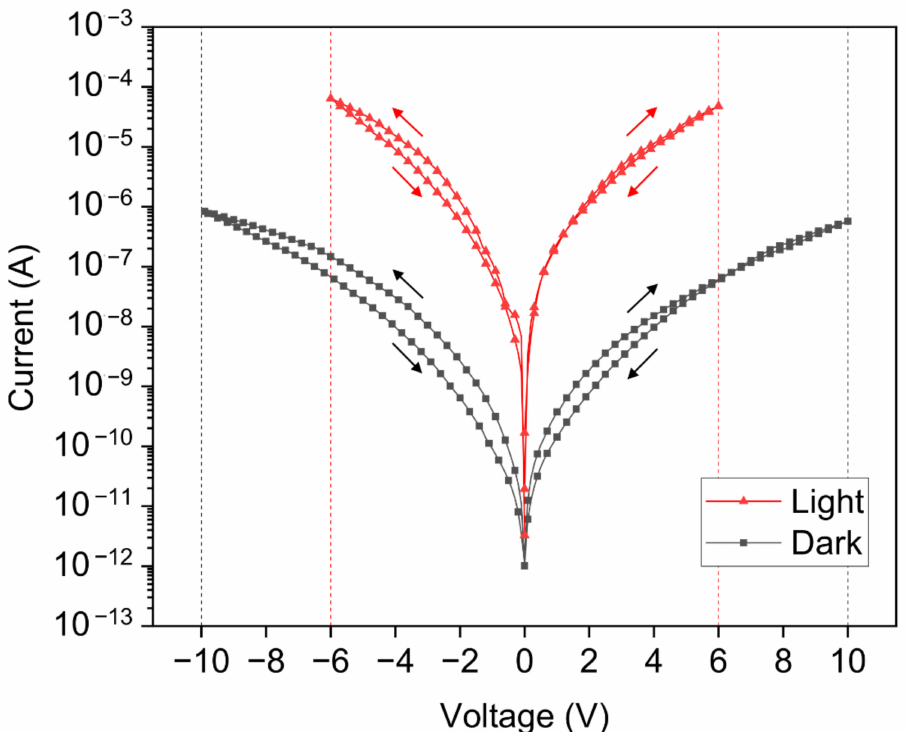
Figure 13. (I-V) characteristics under both dark and light conditions, measured with DC bias modulation. The current is represented on a logarithmic scale with absolute values. The current measurements were performed with an integration time of 200 ms, a step length of 100 mV, a sweep speed of 200 mV · s − 1 and a delay of 300 ms between the step and the measurement. The voltage was swept for dark characteristics between − 10 V and 10 V. The voltage was swept for light characteristics between − 6 V and 6 V. The arrows indicate the parts of the curves corresponding to the forward and backward